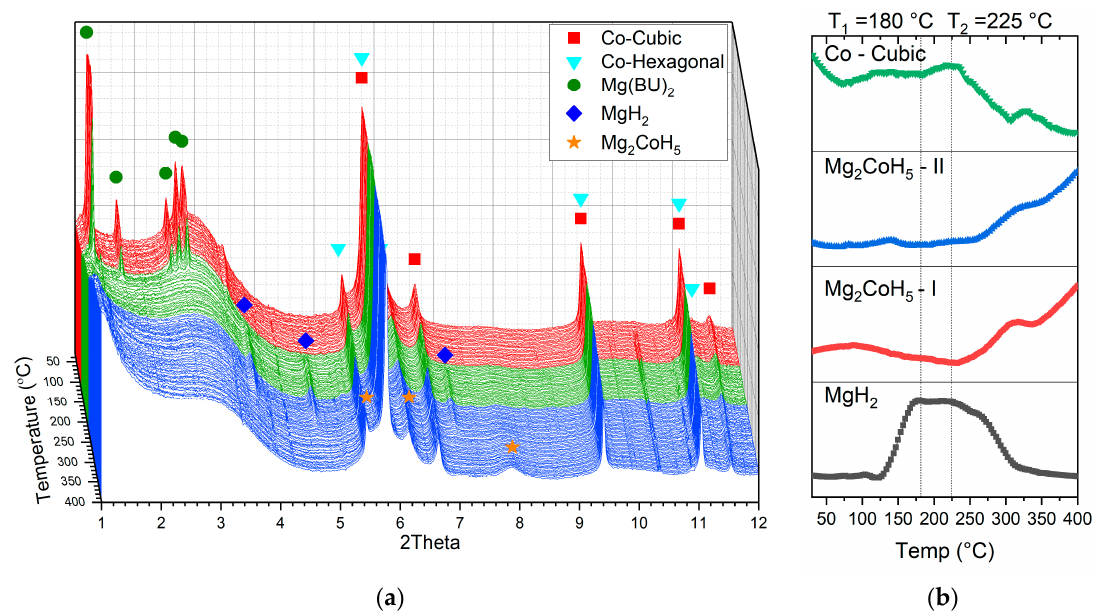
Figure 5. ( a ) In situ synchrotron XRD patterns of a carbon xerogel infiltrated with Co + Mg(Bu) 2 during the temperature-programmed reaction at 100 bar H 2 ; Measurements were performed at DESY, Hamburg ( λ = 0.2072 Å). ( b ) Standardised scale factors of MgH 2 (2 θ = 7.01 ◦ ), Mg 2 CoH 5 (2 θ = 5.49 ◦ & 7.83 ◦ ) and Co-cubic (2 θ = 11.59 ◦ ) as a function of temperature. Data were obtained from sequential Lorentzian peak fit of the in situ di ff raction